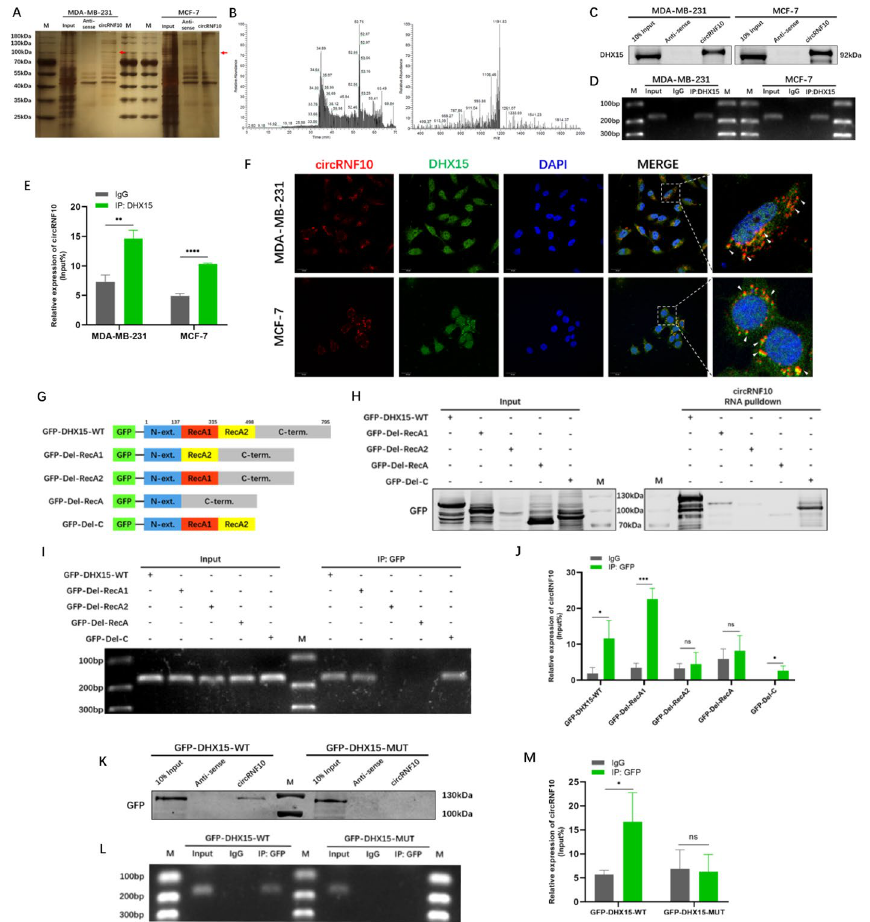
Fig. 3 CircRNF10 interacted with DHX15 in the cytoplasm of BC cells. A Silver staining of the products of RNA pulldown in BC cells by the probe of circRNF10. Red arrow: differential protein band. B Mass spectrometry results of the differential protein band. C Western blotting analysis of the products of RNA pulldown. D RT-PCR analysis of the products of RIP assay in BC cells. E RT-qPCR analysis of the products of RIP assay. F FISH combined with IF to detect the colocalization of circRNF10 and DHX15 in BC cells. Red: circRNF10, green: DHX15, blue: DAPI. White arrows marked the colocalization of circRNF10 and DHX15. G Schematic illustration of the GFP-labeled truncations of DHX15. N-ext: N-extension of DHX15, C-term: C-terminal of DHX15. H Western blotting analysis of the products of RNA pulldown in HEK293T cells, which expressed exogenous DHX15 truncations. I RT-PCR analysis of the products of RIP assay in HEK293T cells that expressed exogenous DHX15 truncations. J RT-qPCR analysis of the products of RIP assay in HEK293T cells that expressed exogenous DHX15 truncations. K Western blotting analysis of the products of RNA pulldown in HEK293T cells that expressed GFP-DHX15-MUT (P327E, T421A, N422K, and Y485E). L RT-PCR analysis of the products of RIP assay in HEK293T cells that expressed GFP-DHX15-MUT (P327E, T421A, N422K, and Y485E). M RT-qPCR analysis of the products of RIP assay in HEK293T cells that expressed GFP-DHX15-MUT (P327E, T421A, N422K, and Y485E). Error bars represent the mean SD. * P < 0.05, ** P < 0.01, *** P < 0.001, **** P < 0.0001, ns: no ±